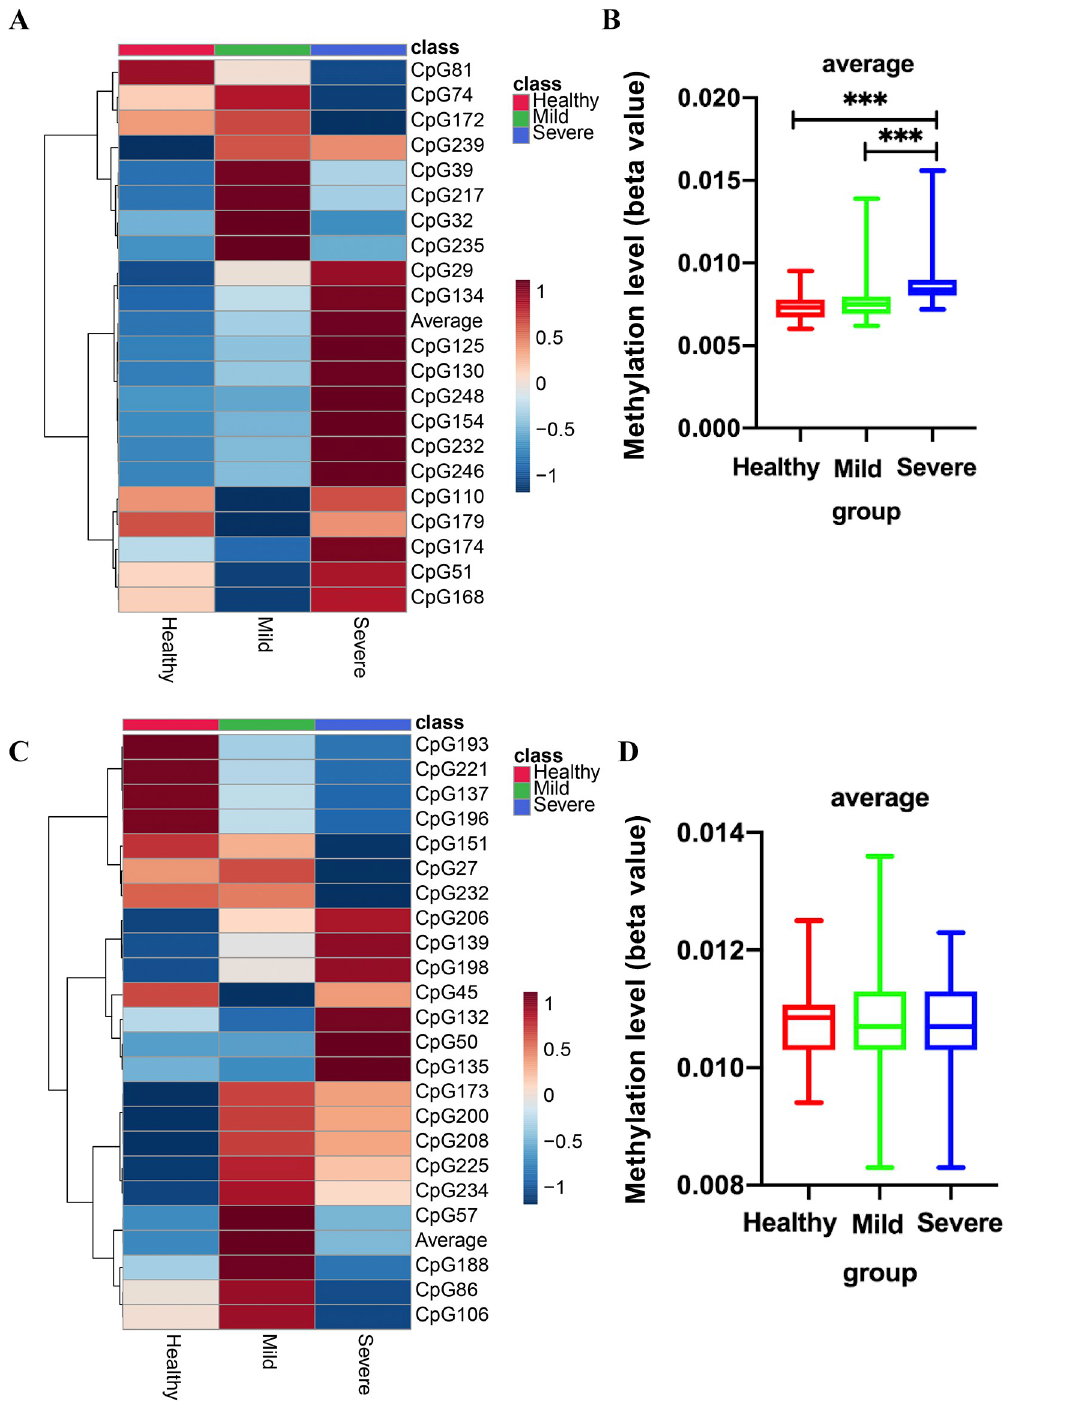
Fig 1. The methylation patterns of DDX58 and IFIH1 in EV71-HFMD patients and healthy controls. Each colored cell on the heatmap corresponds to an average concentration value in different groups. The methylation patterns of DDX58 in EV71-HFMD patients and healthy controls (A). DDX58 methylation levels of all samples, including healthy subjects and EV71-HFMD patients (B). The methylation patterns of IFIH1 in EV71-HFMD patients and healthy controls. (C). IFIH1 methylation levels of all samples, including those of healthy subjects and EV71-HFMD patients (D). ��� p < 0.001.